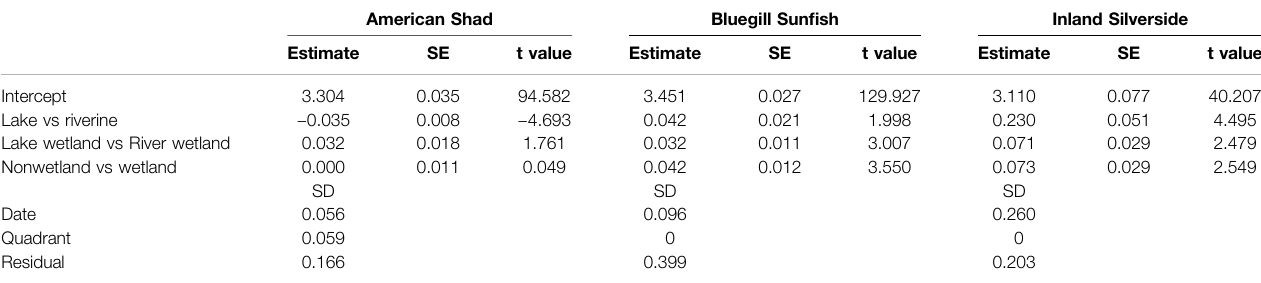
TABLE 8 | Statistical model results for fi xed and random effects in the length analyses for all three